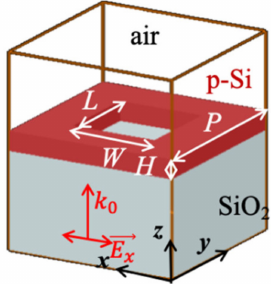
Figure 1. Schematic of the studied unit-cell in which a Si rectangular nanohole (length L , width W , height H ) is located on a SiO 2 substrate. The lattice period is constant P = 600 nm. The x-polarized incidence is injected from the